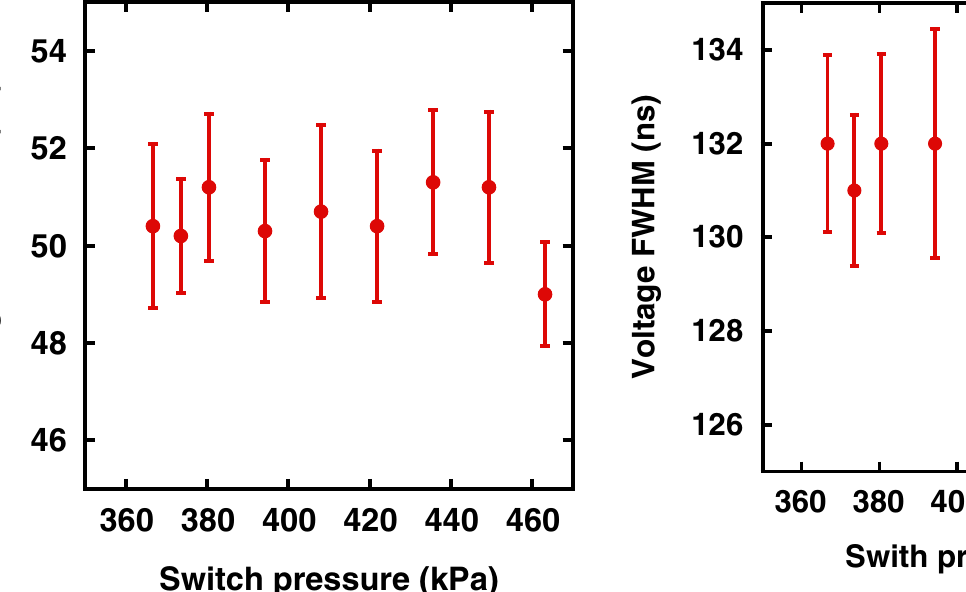
FIG. 18. (Color) Average output pulse full width at half maxi- mum (FWHM) for a number of switch pressures. The charge voltage was always (cid:2) 100 kV .